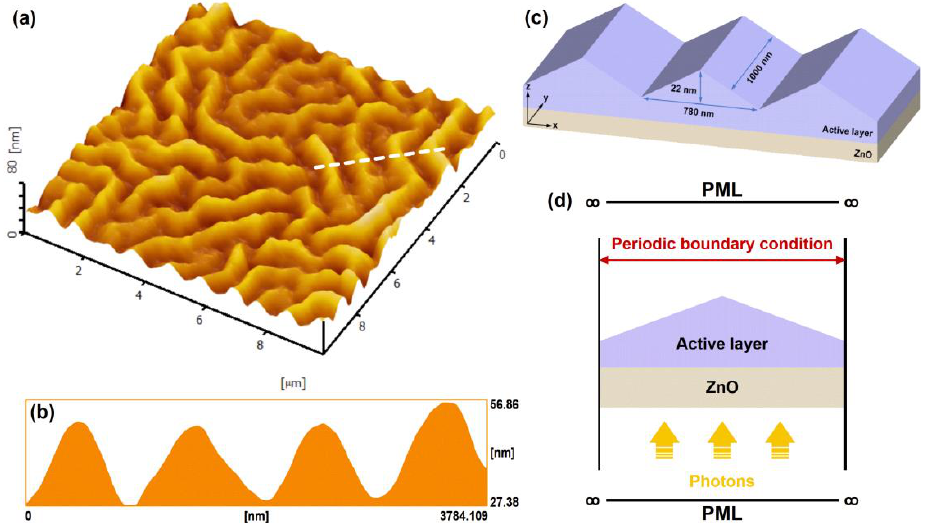
Figure 2. ( a ) Top view and ( b ) side view of the AFM images of the PTB7-Th:PC 70 BM:PC 60 BM blend film with SANR structures, ( c ) schematic diagram of the numerical model, and ( d ) side view of the unit cell of the simulation model.